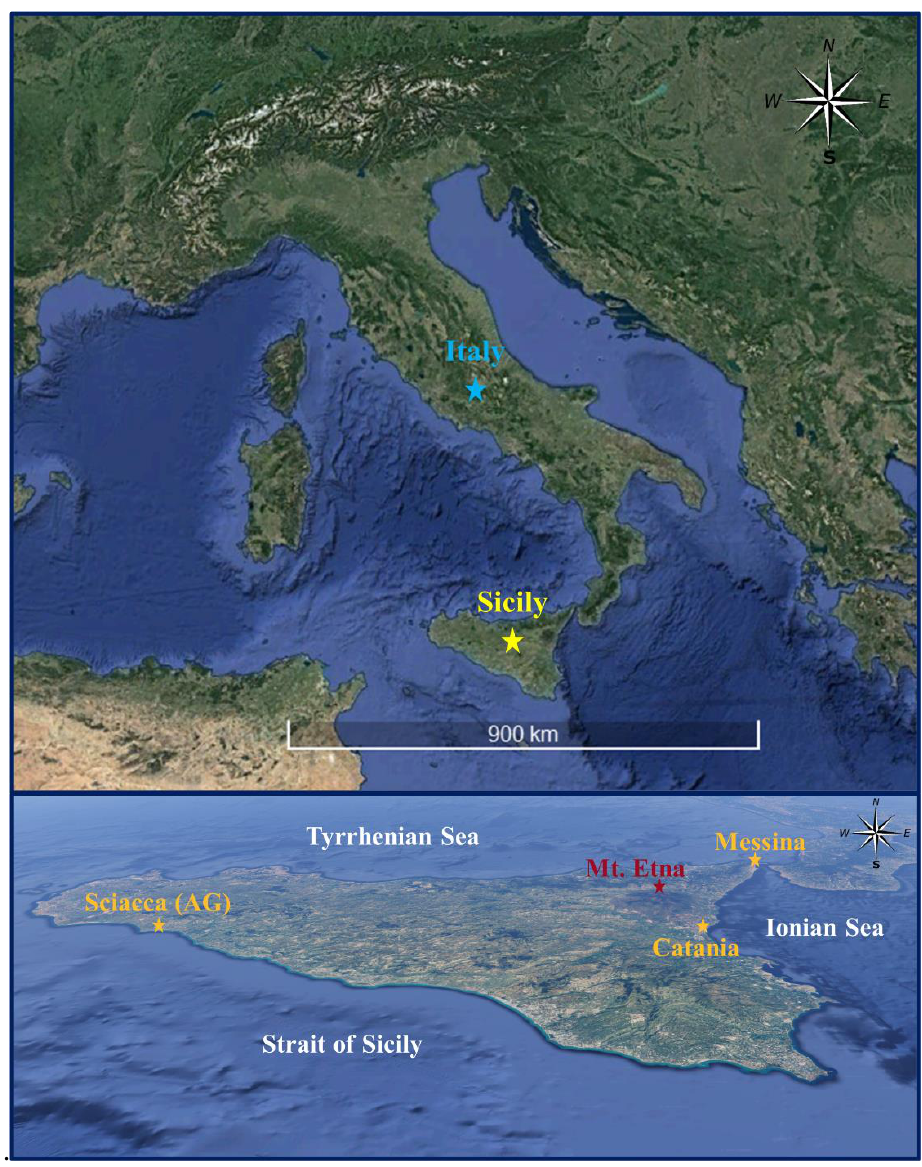
Figure 1. Top panel: map showing the location of Sicily in Europe. Bottom panel: Detail of Sicily showing the geographical position of the cities of Messina, Catania, and Sciacca; the seas; and Mount Etna.